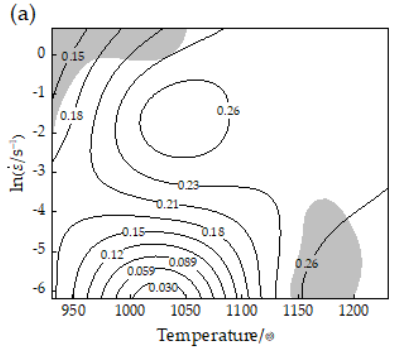
Figure 9. Power dissipation maps for the 20MnCr5(SH) gear steel at strains of ( a ) 0.1; ( b ) 0.2; ( c ) 0.3; ( d ) 0.4; ( e ) 0.5; ( f ) 0.6.